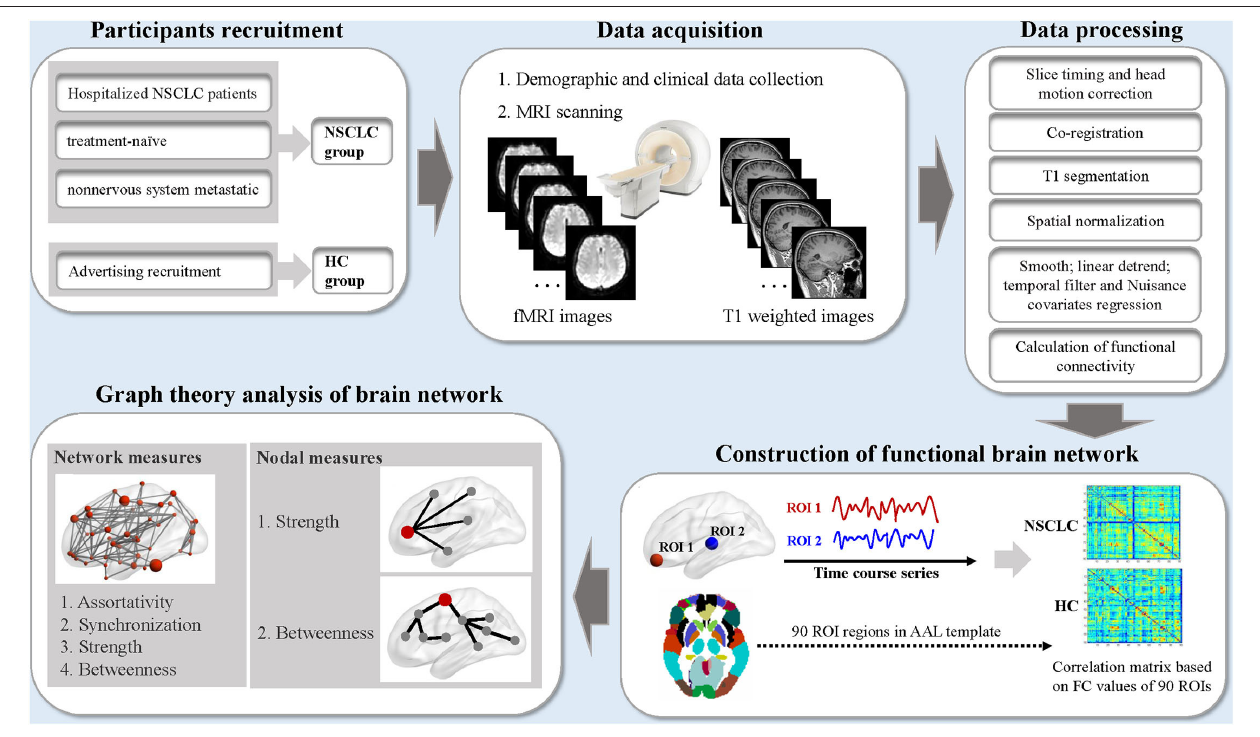
FIGURE 1 | The schematic diagram for the acquisition, preprocessing, and graph theoretical analysis of resting-state functional MRI data in this study. NSCLC, non-small cell lung cancer; HC, healthy control; fMRI, functional MRI; ROI, region of interest; AAL, anatomic automatic labeling. MRI data were processed by the Data Processing Assistant for Resting State fMRI software (DPARSF). The nodal and network measures of the functional brain network were calculated by using the GRaph thEoreTical Network Analysis (GRETNA)